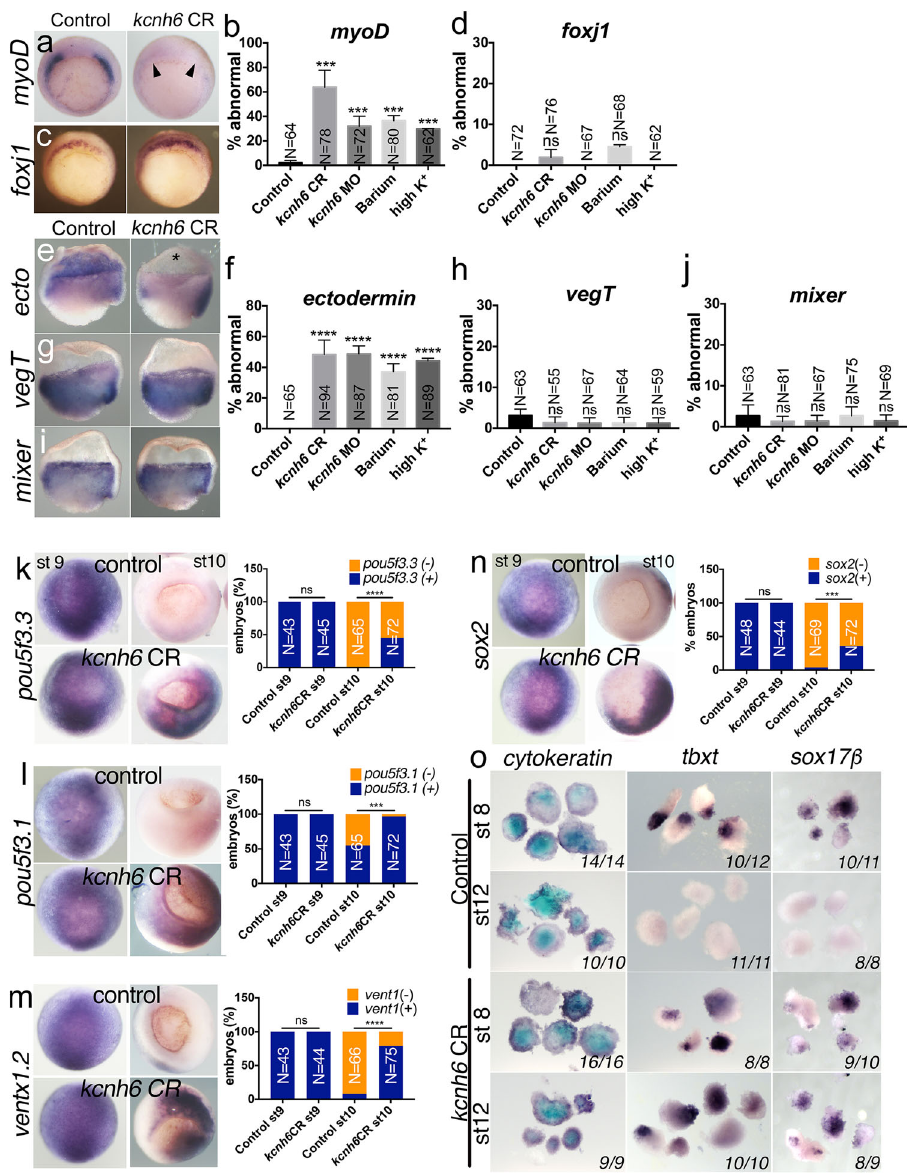
Fig.4|Membranepotentialaffectsearlygastrulapatterningandpluripotency. a – j WMISHforgerm-layermarkersinearlygastrulaembryos(stage10; a , c